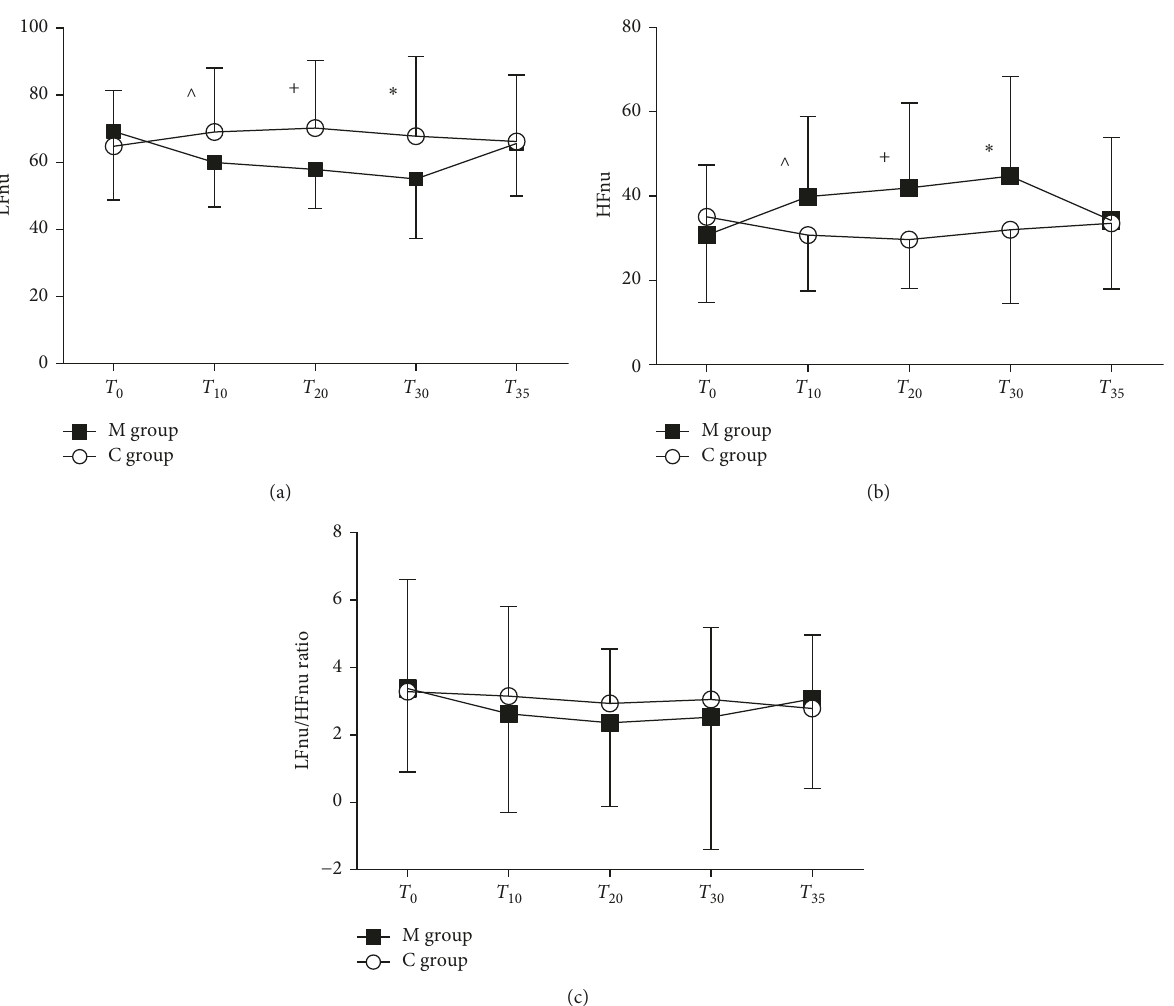
Figure 6: Heart rate variability. (a) Normalized low frequency (LFnu), (b) normalized high frequency (HFnu), and (c) LF/HF ratio in the music group (M group) and control group (C group) at each time point. Data are presented as mean p 0 . (cid:31) ∗